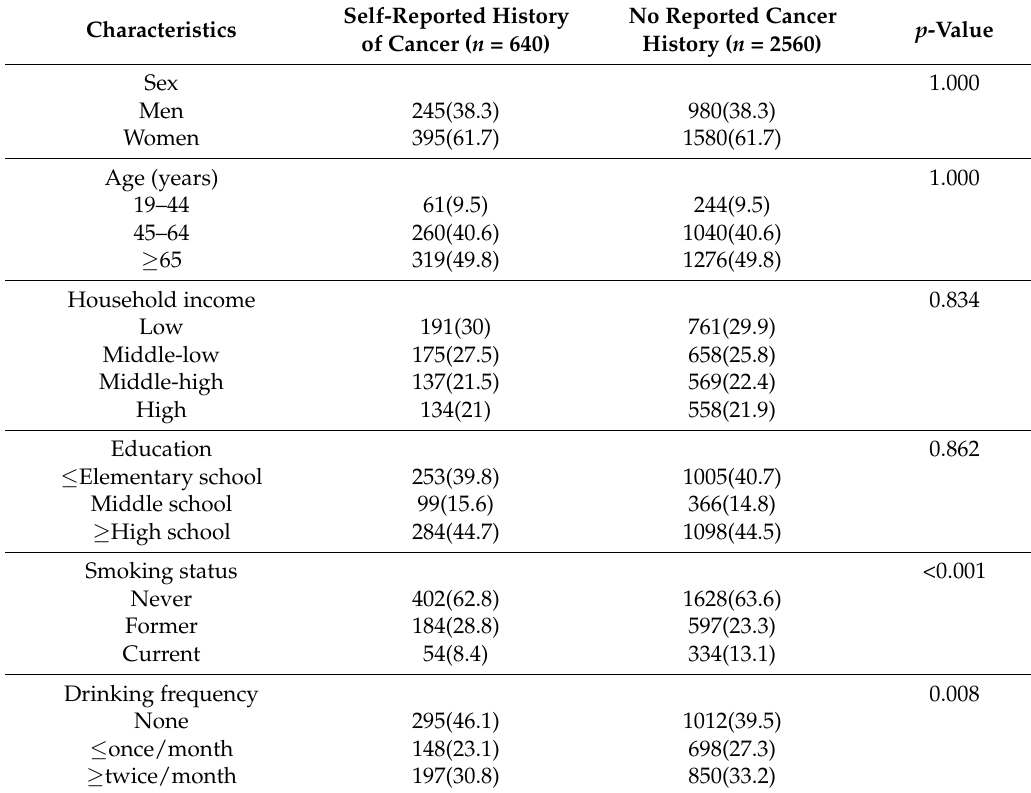
Table 1. Characteristics of cancer survivors and control